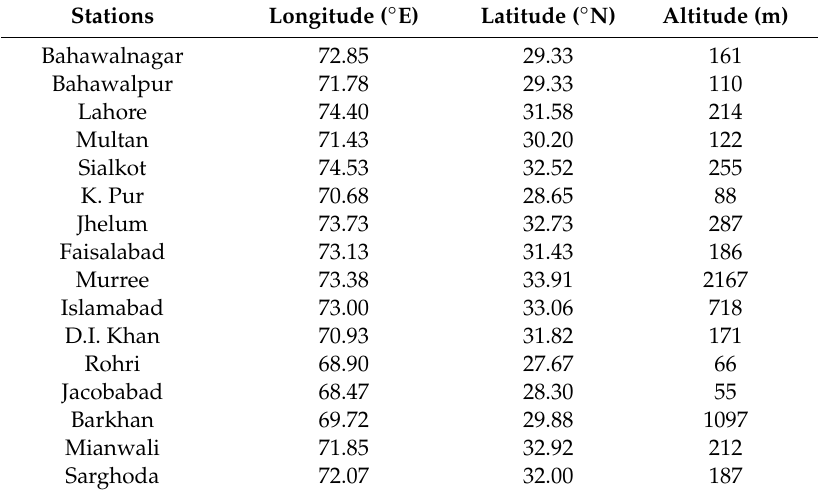
Table 1. Information of Meteorological stations in